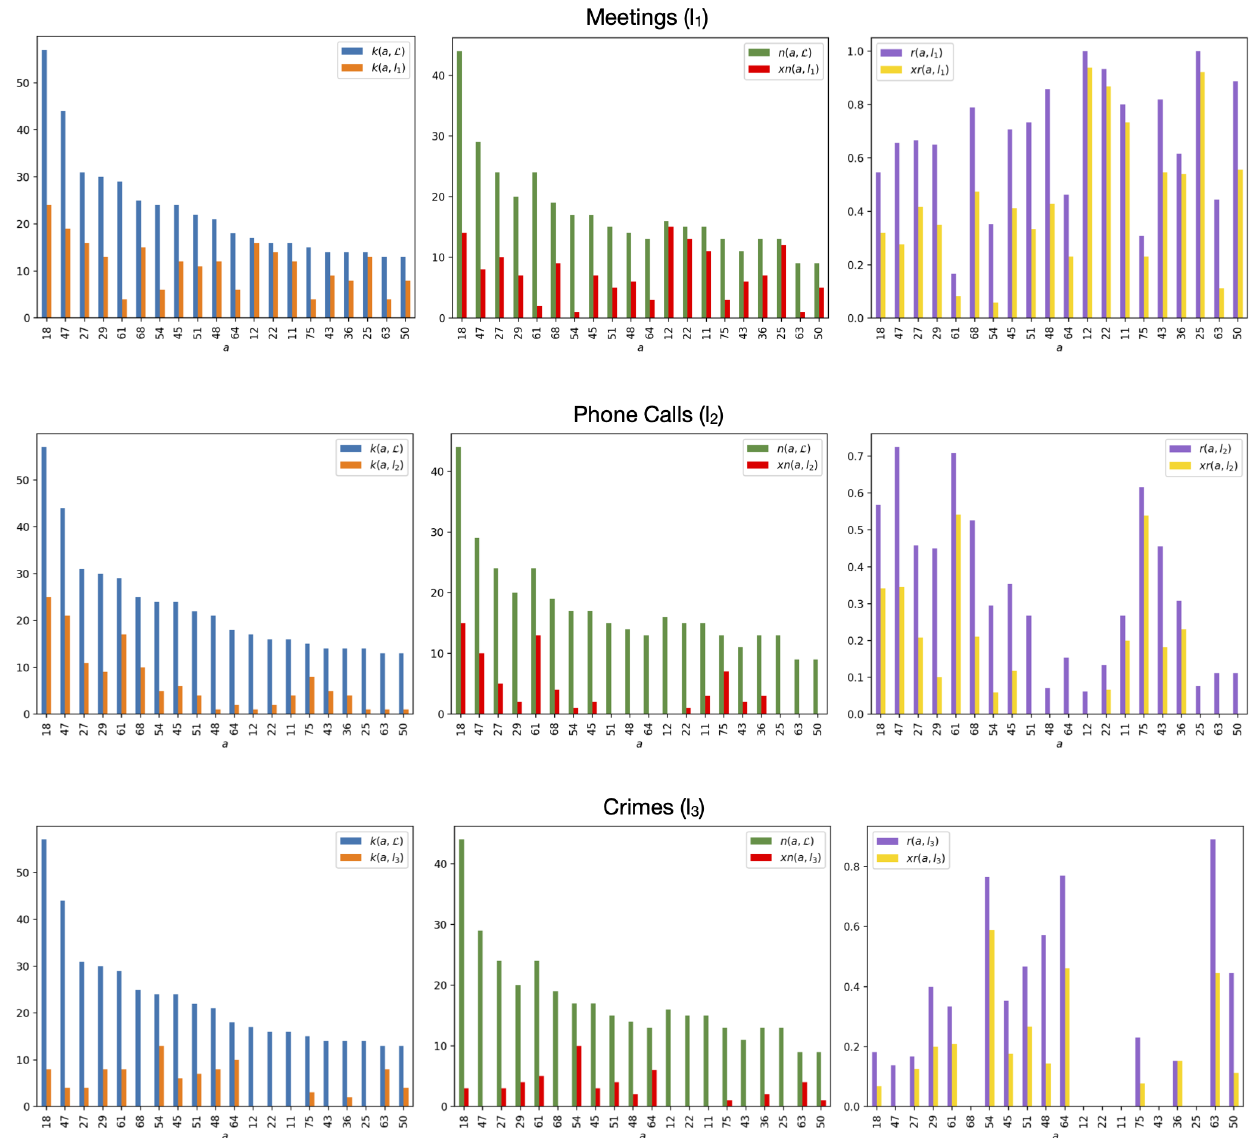
Figure 2. Degree k ( a , ) and neighborhood n ( a , ) computed on all the three layers L with degree k ( a , l ) , exclusive neighborhood xn ( a , l ) , relevance r ( a , l ) and exclusive relevance xr ( a , l ) computed on each of the three layers Meetings ( l 1 ), Phone Calls ( l 2 ) and Crimes ( l 3 ) for each actor a of the 20 highest-degree actors.